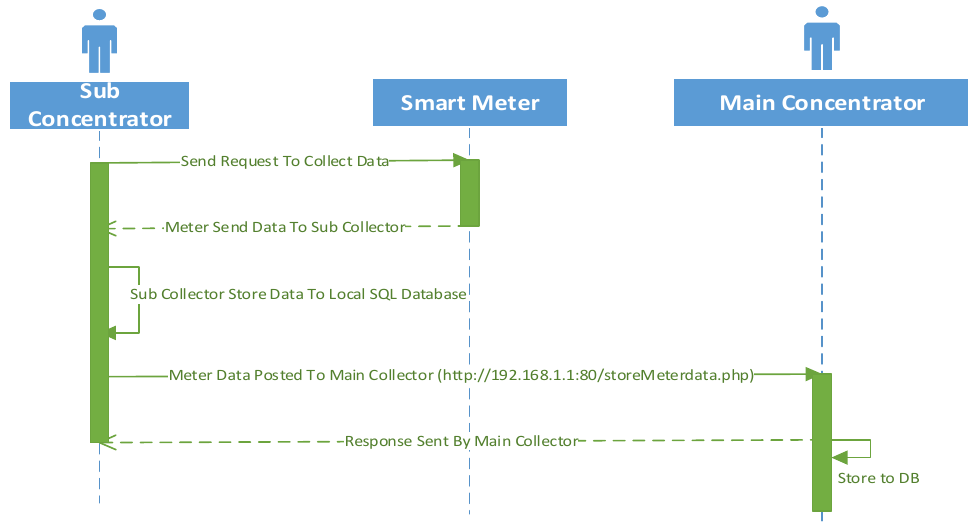
Figure 9. Sequence Diagram for Large Scale Data Concentrator.